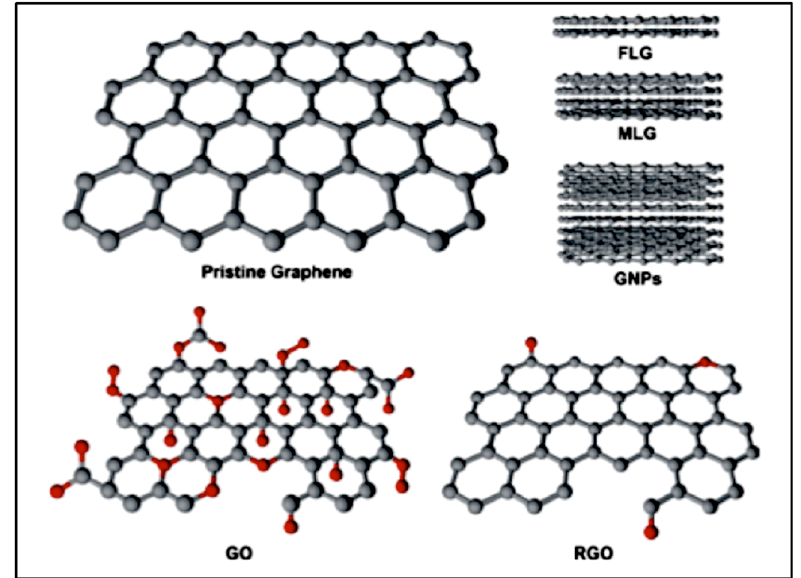
Figure 2: Graphene derivatives where grey sphere refers to carbon atom and red spheres refer to functional groups such as hydroxyl ( – OH ) , alkoxy ( C – O – C ) , and carboxylic acid ( – COOH ) . Reproduced from ref. [ 38 ]